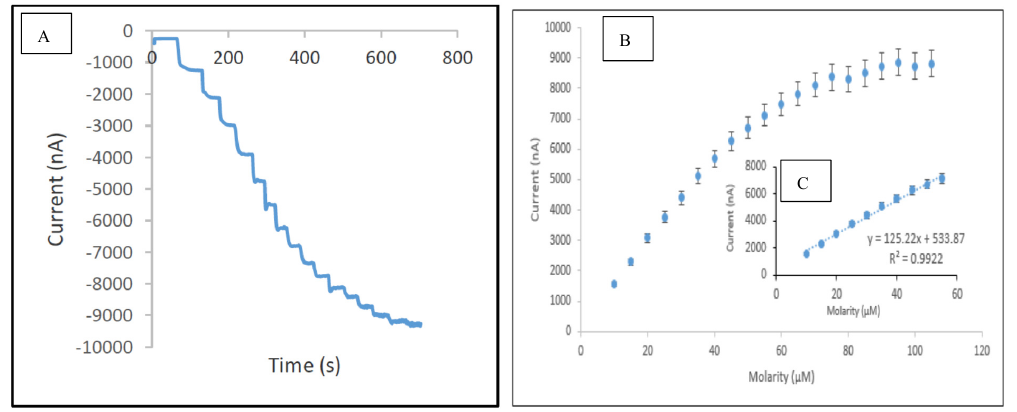
Figure 10. Typical current-time response curve ( A ); calibration curves for the concentration of phenol range 10–120 µM ( B ); and concentration of phenol range 10–55 µM ( C ) obtained with SPCE/CTAB/PEG-ZrO 2 /Tyr.